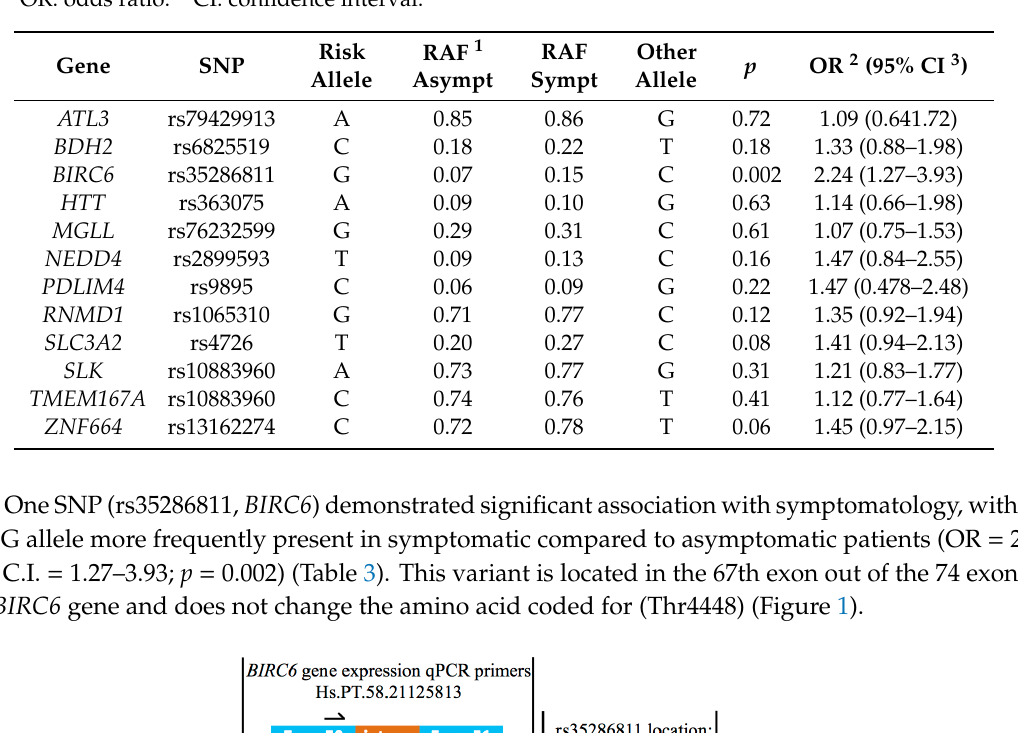
1 Bp: base pairs. 2 Flags indicate the transcript support level (TSL) of each isoform. 3 Avg GE: average gene expression counts obtained from RNA-Seq